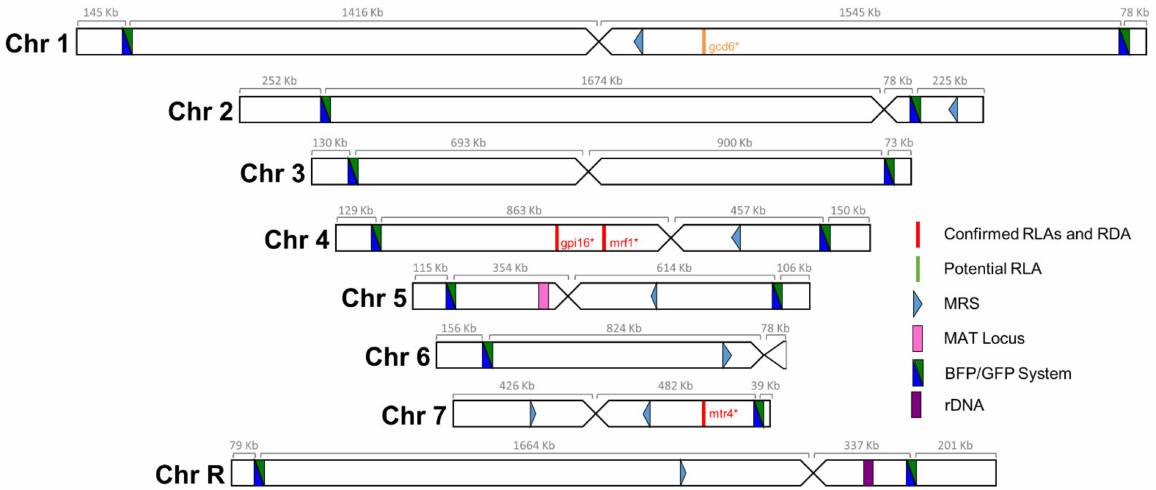
Figure 2. Blue-Green collection. Positions of the BFP/GFP system insertions utilized to measure LOH frequencies. Distances, in kb, between the telomere and the LOH reporter system and the centromere is indicated above each chromosome. Additionally, illustrated are the locations of known recessive lethal alleles (RLA) and recessive deleterious alleles (RDA), major repeat sequences (MRS), mating-type like (MTL) locus, and ribosomal DNA (rDNA)